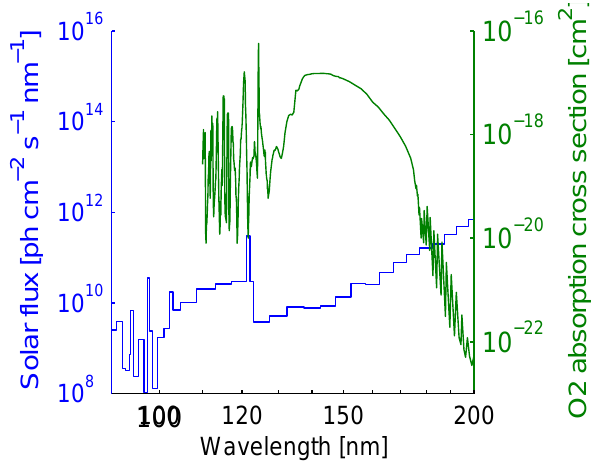
Fig. 2. The penetration of direct and geocoronal Lyman- α into the mesosphere. The geocoronal contribution (grey line) is almost inde- pendent of the solar position and dominates at typical NLC altitudes for solar zenith angles greater than 90 ◦